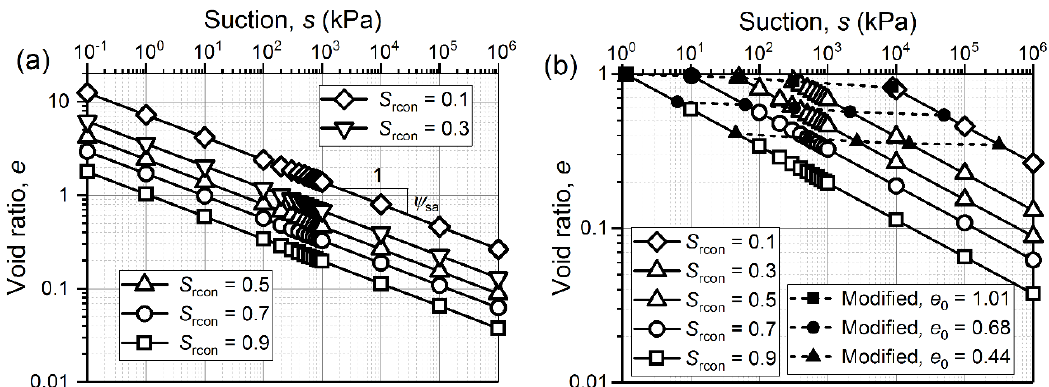
Figure 14. Retention consolidation curves at different constant degree of saturation at (data from Salager et al. [36]): ( a ) initial void ratio e 0 = 0.44; ( b ) different initial void ratios along with modifying lines.